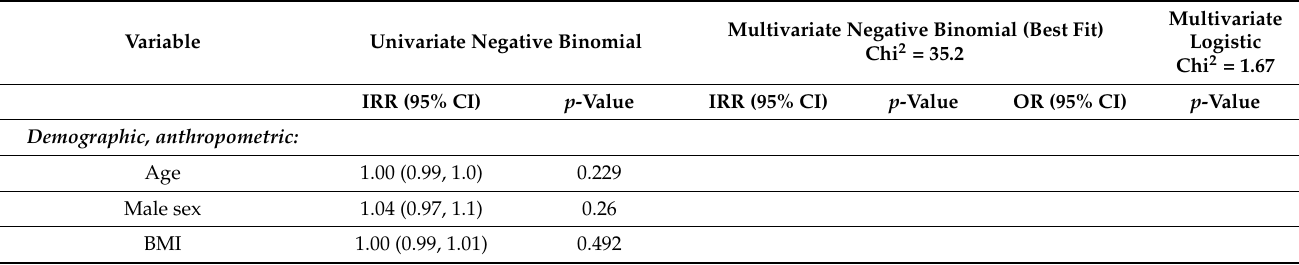
Table 3. Regression